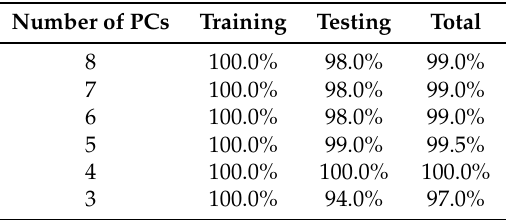
Table 5. Accuracy rate using different principal